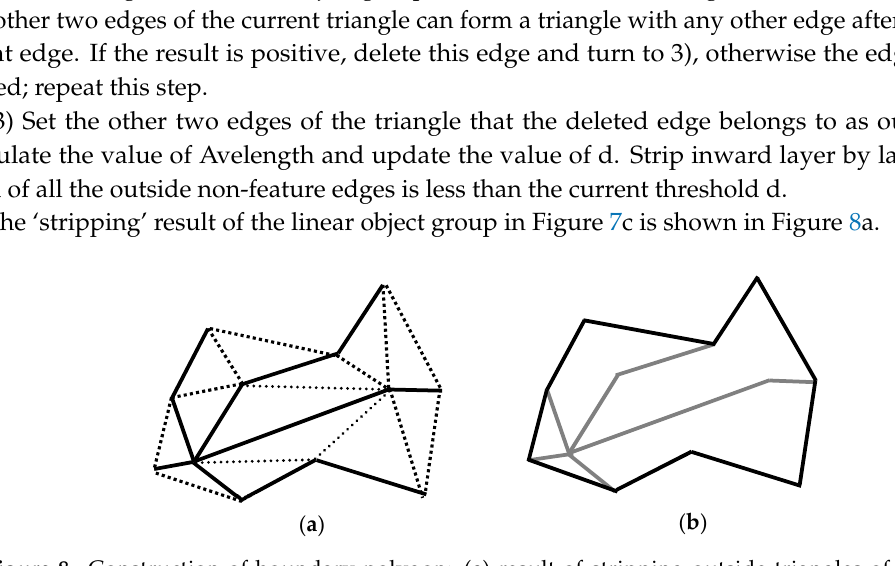
Figure 8. Construction of boundary polygon: ( a ) result of stripping outside triangles of the road segments and ( b ) the final boundary polygon.